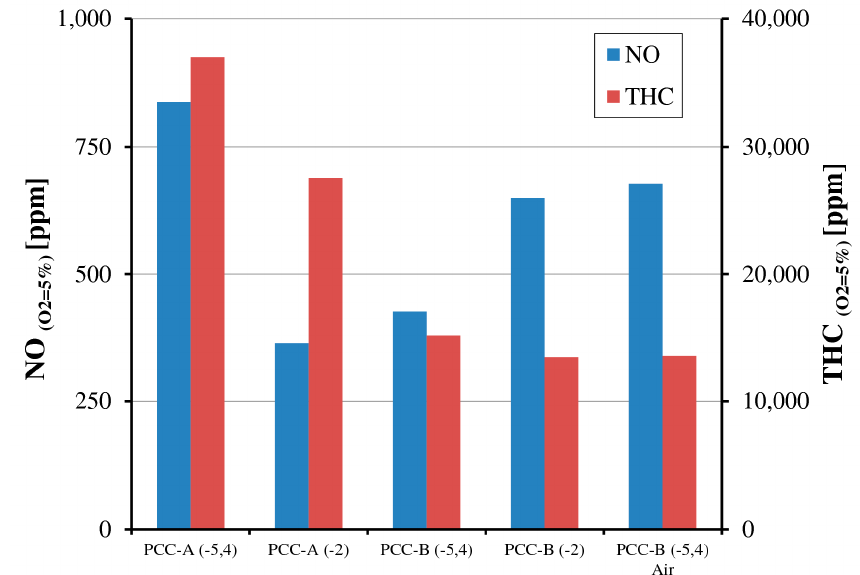
Figure 8. Emission of toxic compounds versus ignition time.